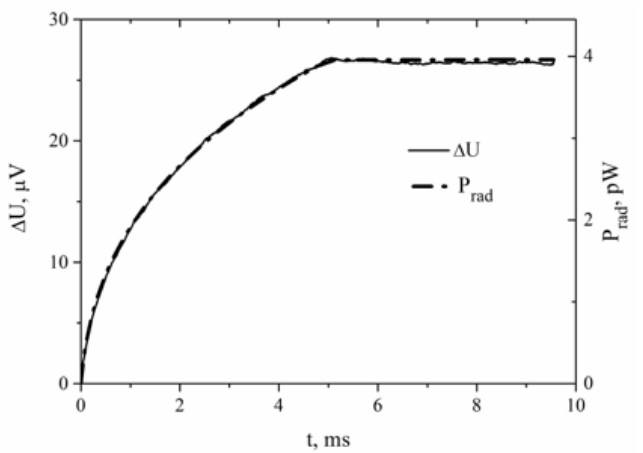
Figure 14. Solid line indicates detector response to source radiation when 7 V pulse was applied for 5 ms. Dashed line indicates calculated radiation power, Reprinted with permission from Ref. [12],